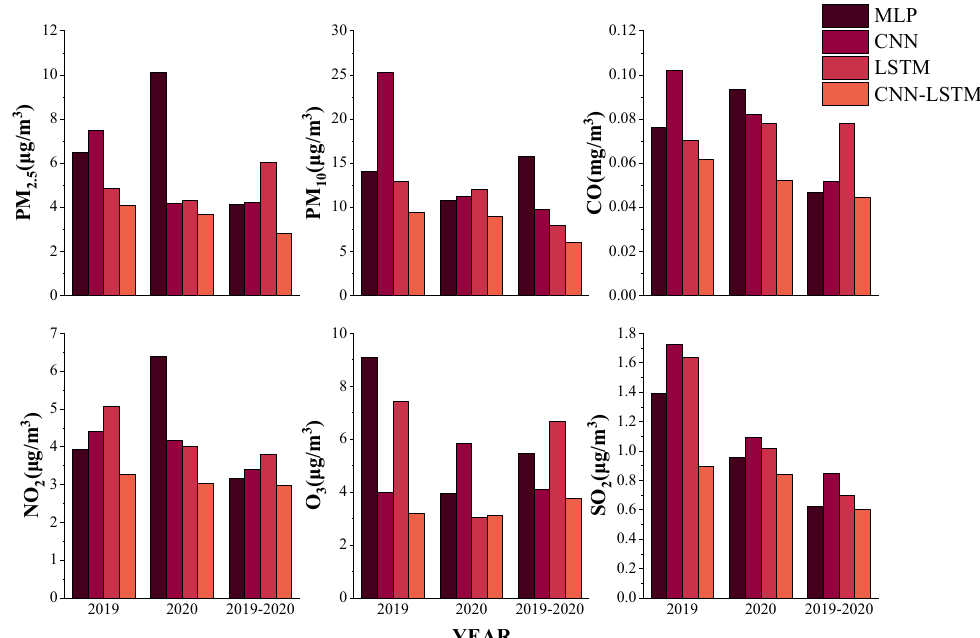
Figure 10. Comparison of the four models predicted MAE for six air pollutants in 2019, 2020, and 2019–2020.